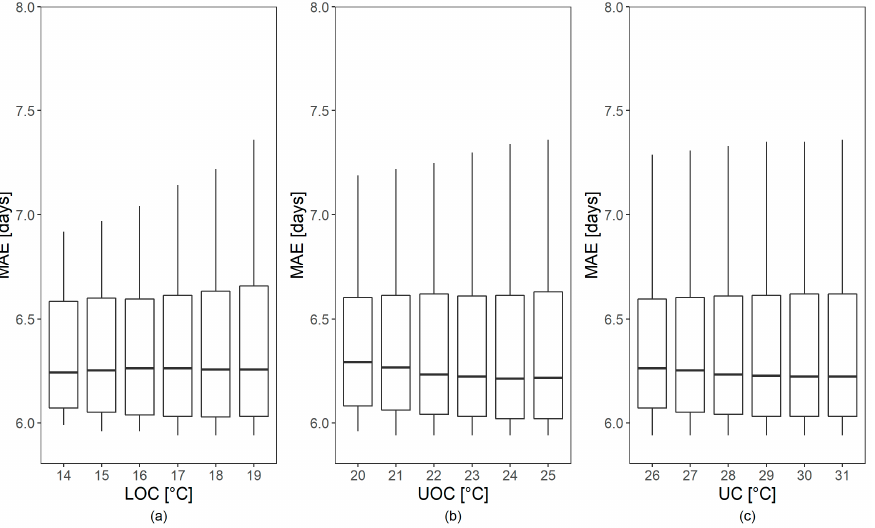
Figure 6. Boxplots of MAE values obtained with 5814 different combinations of NHH parameters, considering the starting date at DOY 69, in relation to the studied ranges of LOC, UOC and UC.